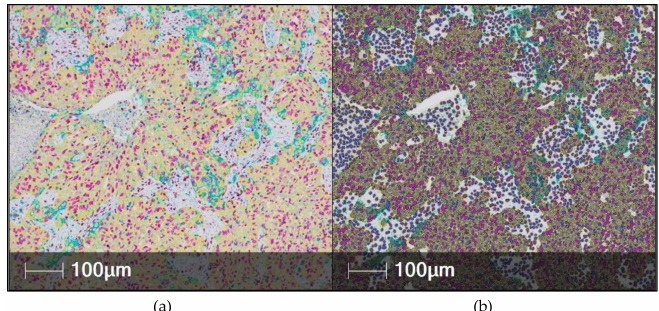
Figure 6. Automated digital analysis of multiplexed immunohistochemistry (mIHC) using the HALO software in non-small cell lung cancer tissue. ( a ) The mIHC image was scanned with a Nanozoomer 2.0-HT Scanner (Hamamatsu photonics, Hamamatsu, Japan) using 20x magnification. The stains are as follows: Pan-cytokeratin (yellow), CD8 (brown), Ki67 (purple), PD-L1 (teal) and hematoxylin (dark purple). ( b ) The HALO mark-up image shows colors similar to the original stain color and in the same cell compartment (nucleus/cytoplasm/membrane as the stain is found. The user can select different colors to be used in the mark-up image if they